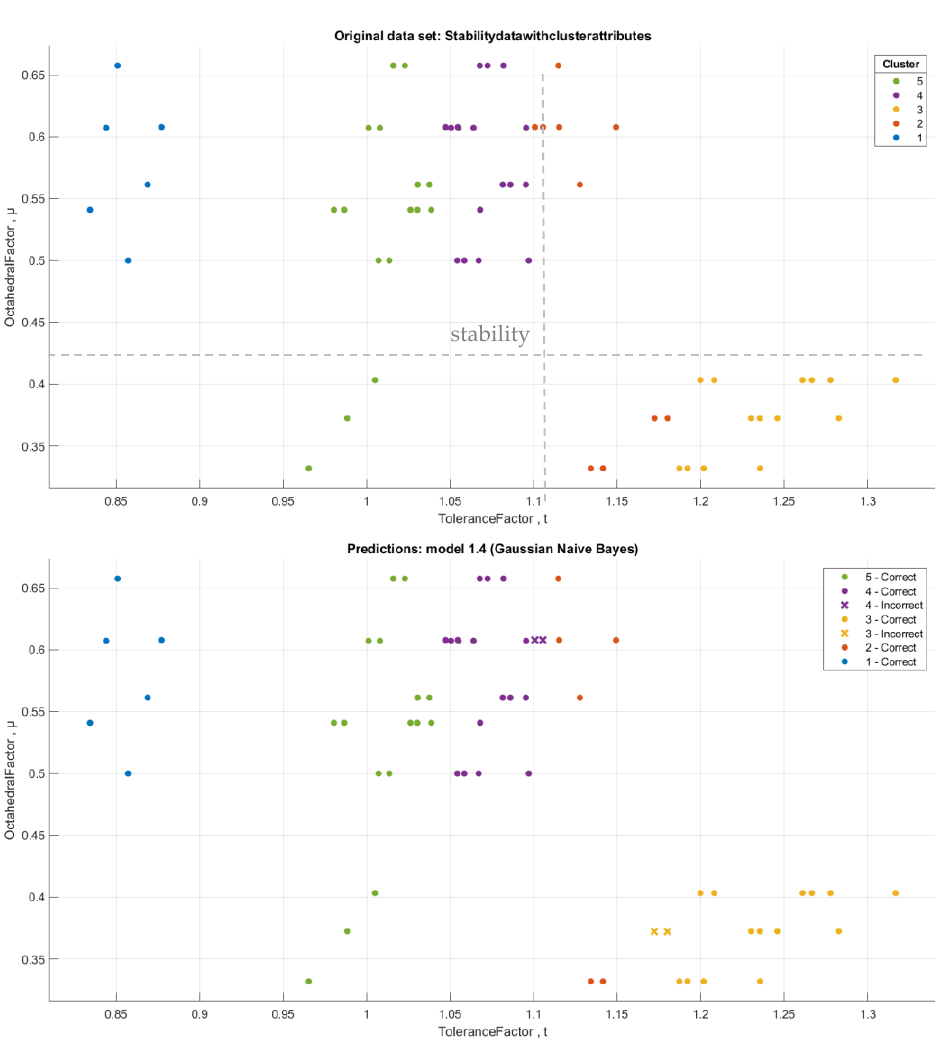
Figure 10. The classification error representation of the Gaussian Naive Bayes classifier, where x points represent the incorrect classification of data.